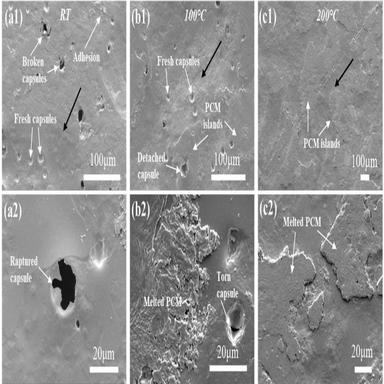
SEM micrographs of ATSP + MPCM after 30 min tribological experiment at (a) RT, (b) 100 ◦C, and (c) 200 ◦C.